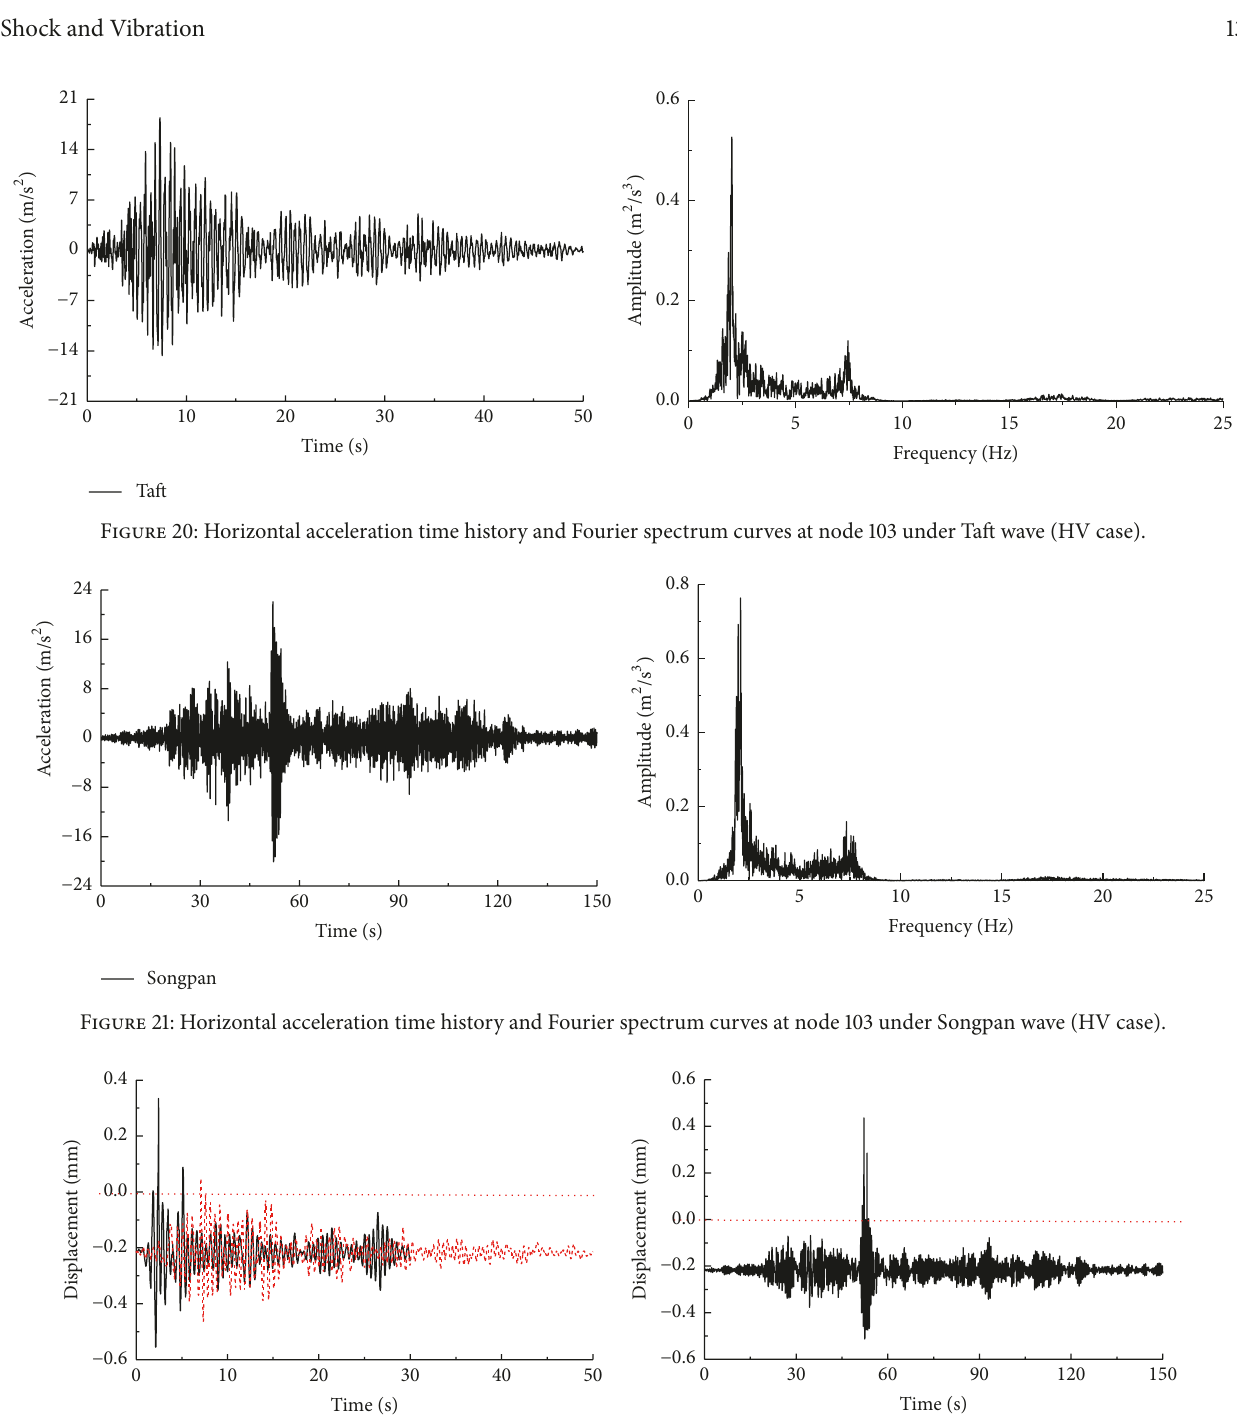
the influence of structure stiffness on the dynamic response of structure, the total structural mass remains unchanged, while the structural stiffness is strengthened by increasing material modulus. In this case, the modulus of material is set to 75 GPa after using trial and error method to make the natural frequency of structure close to that in the first